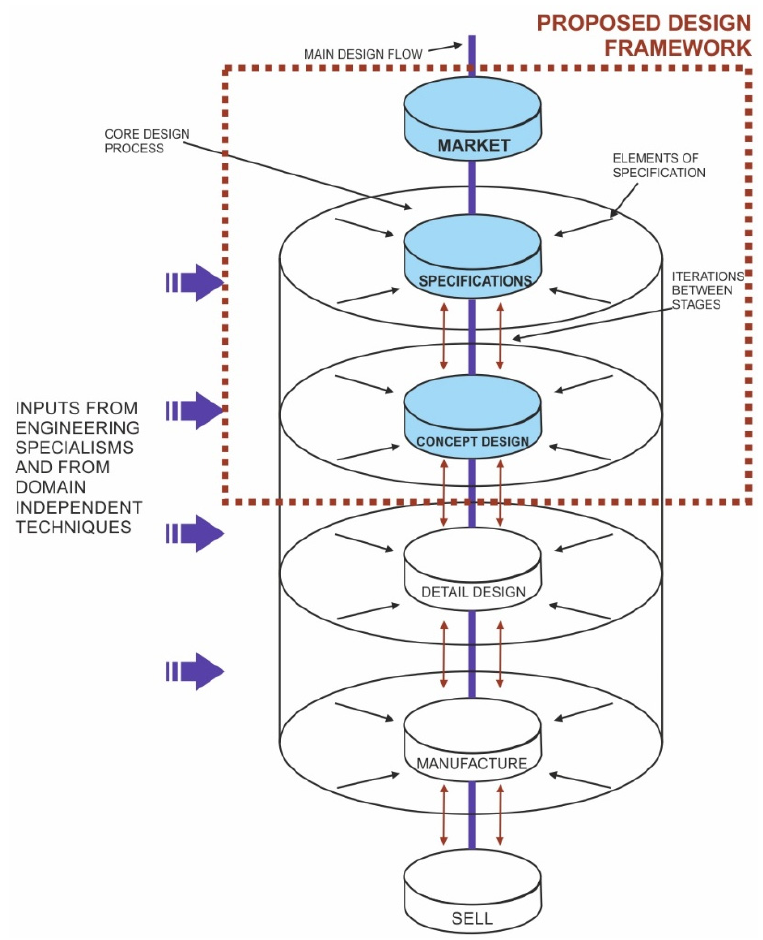
Figure 2. Graphic representation of the Pugh’s Total Design model. Based on [34].